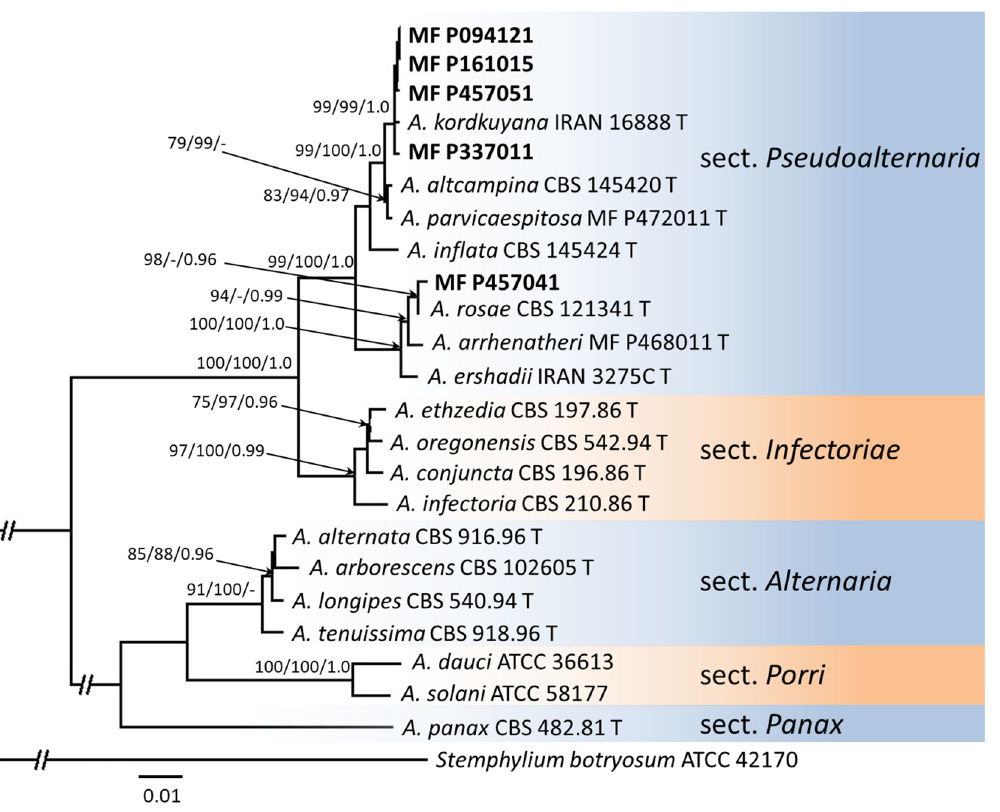
Figure 1. Maximum likelihood phylogenetic tree for Alternaria section Pseudoalternaria species inferred from combined gpd and ATP gene sequences. Bootstrap percentages from maximum ‐ likelihood/maximum parsimony (>70%) and Bayesian posterior probabilities (>0.95) are given at the nodes. The strain Stemphylium botryosum ATCC 42170 was used as an outgroup.